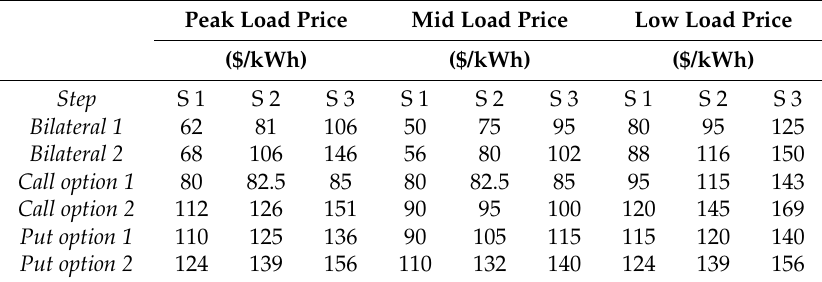
Table 7. Data of contracts’ offered price steps.